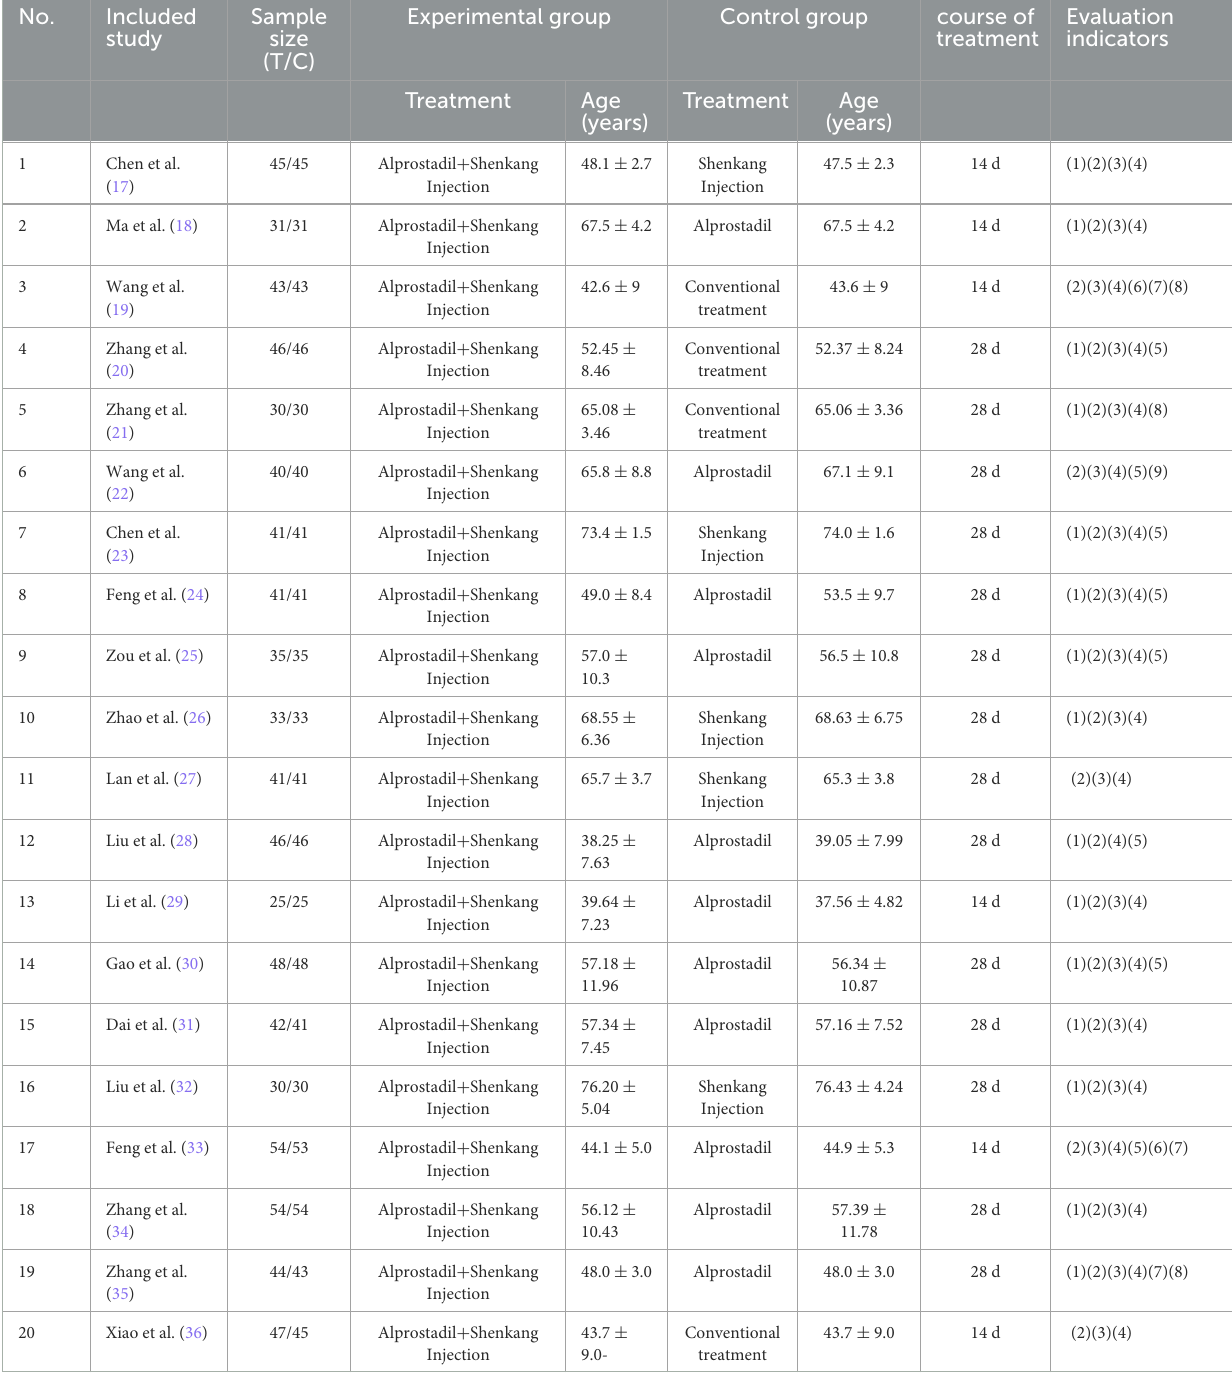
TABLE 1 Principal characteristics of the studies included in the